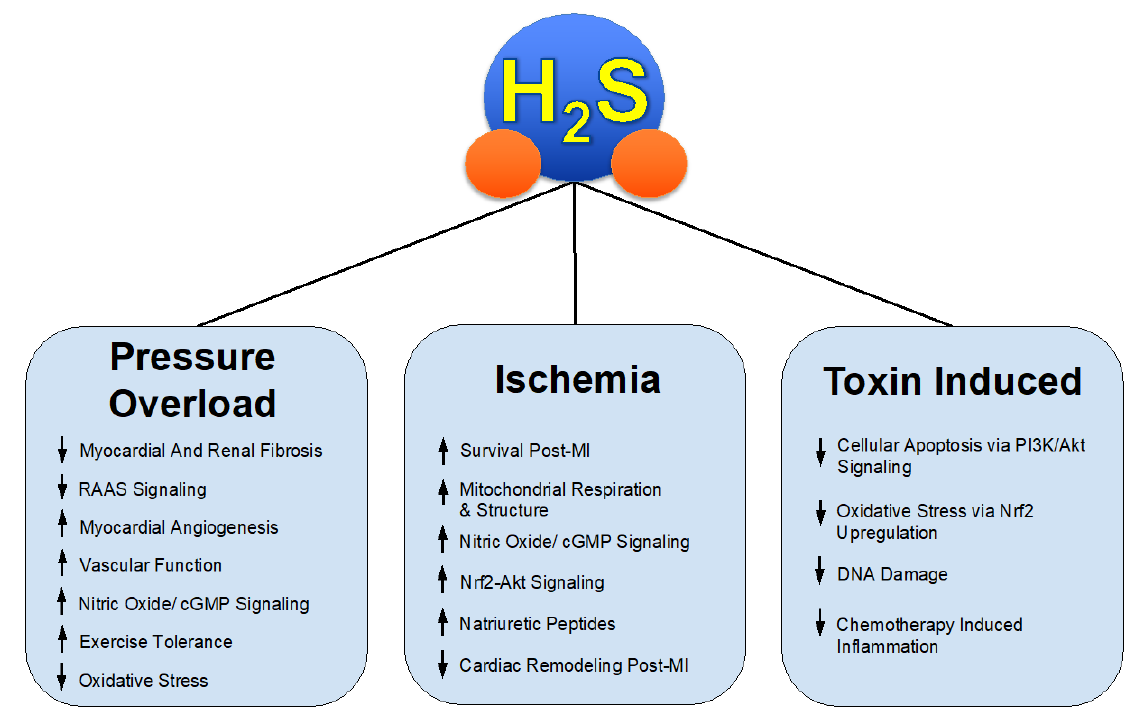
Figure 1. H 2 S Mediated Protection in Heart Failure.